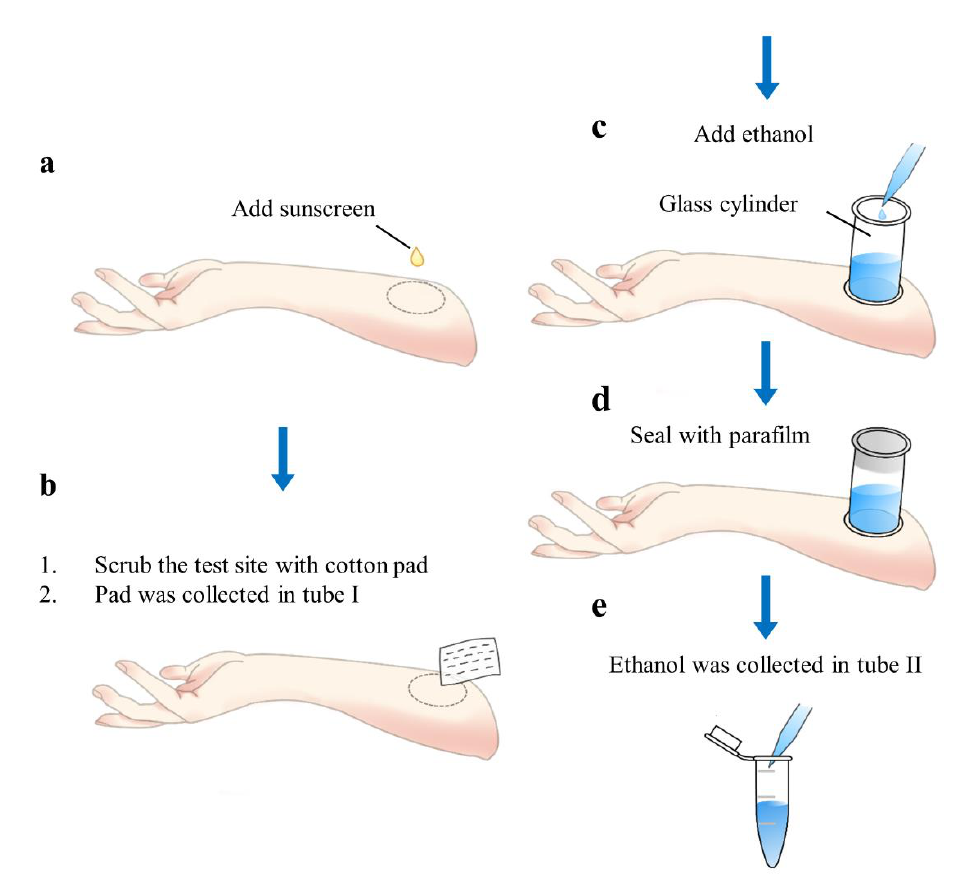
Figure 1. Depicting the cup method.